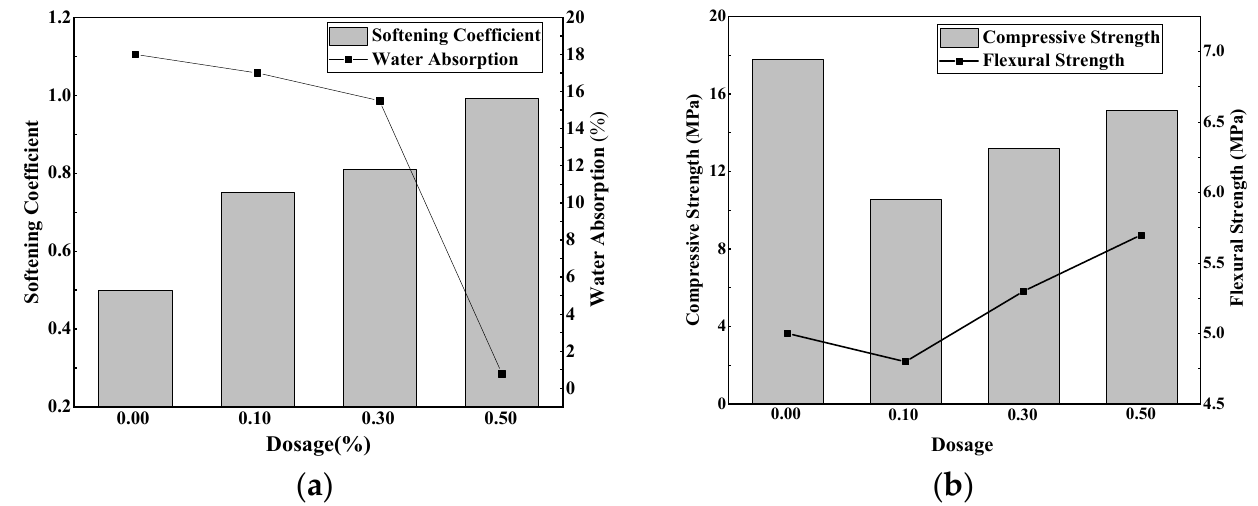
Figure 2. Influence of different hydrophobic agent dosages on the phosphogypsum at 7d. ( a ) Softening coefficient and water absorption rate; ( b ) Compressive strength and flexural strength.